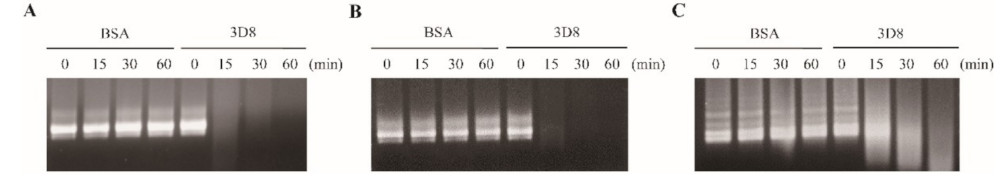
Figure 1. RNA-hydrolyzing activity of 3D8 for in vitro transcripts of severe acute respiratory syndrome coronavirus-2 (SARS-CoV-2), human coronavirus OC43 (HCoV-OC43), and porcine epidemic diarrhea virus (PEDV) . ( A ) Nuclease activity of 3D8 against SARS-CoV-2. In vitro transcripts of SARS-CoV-2 were prepared and treated with 3D8. ( B ) Nuclease activity of 3D8 against HCoV-OC43. In vitro transcripts of HCoV-OC43 were prepared and treated with 3D8. ( C ) Nuclease activity of 3D8 against PEDV. In vitro transcripts of PEDV were prepared and treated with 3D8. Hydrolysis activity was determined by electrophoresis and observed under UV